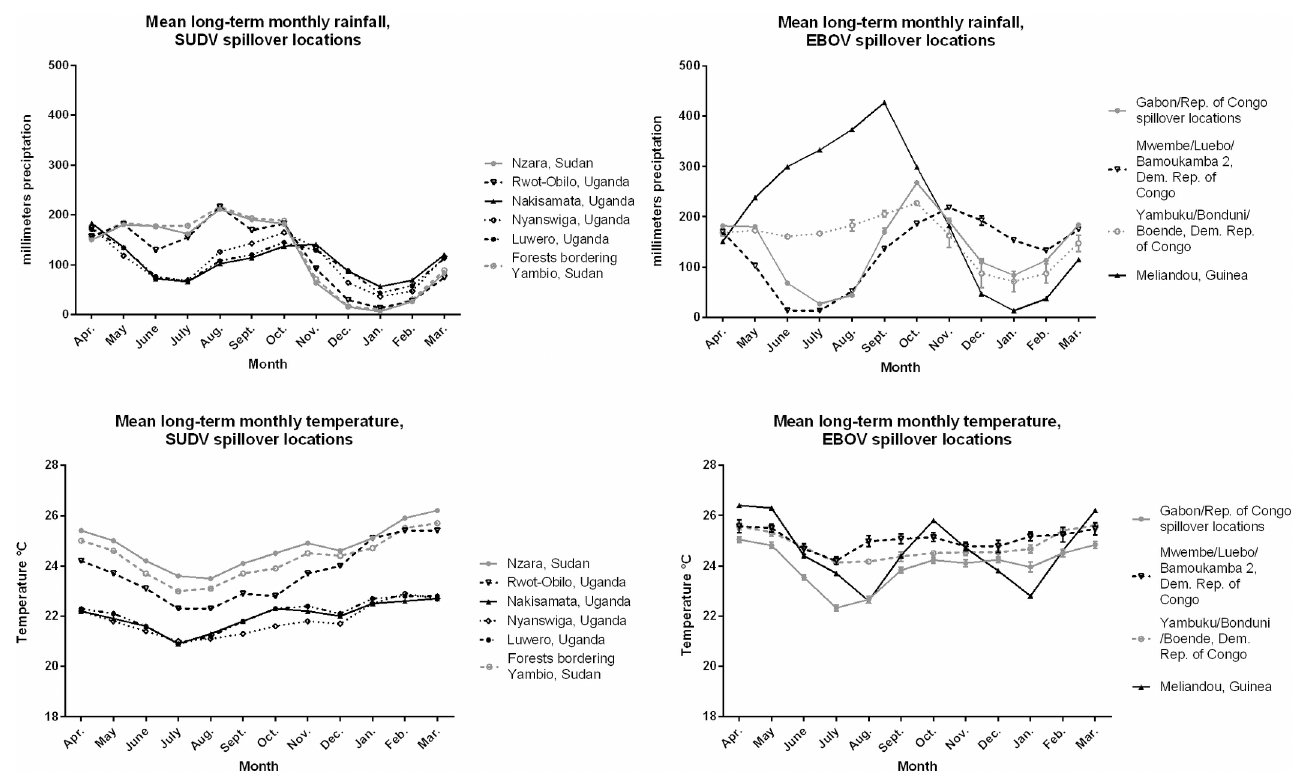
Fig 3. Monthly rainfall and temperature in SUDV and EBOV index case locations. The mean long-term monthly rainfall and temperature for the six SUDV spillover locations are depicted. For the twenty EBOV spillover locations, the mean rainfall and standard error of the mean are shown for locations that were in proximity to each